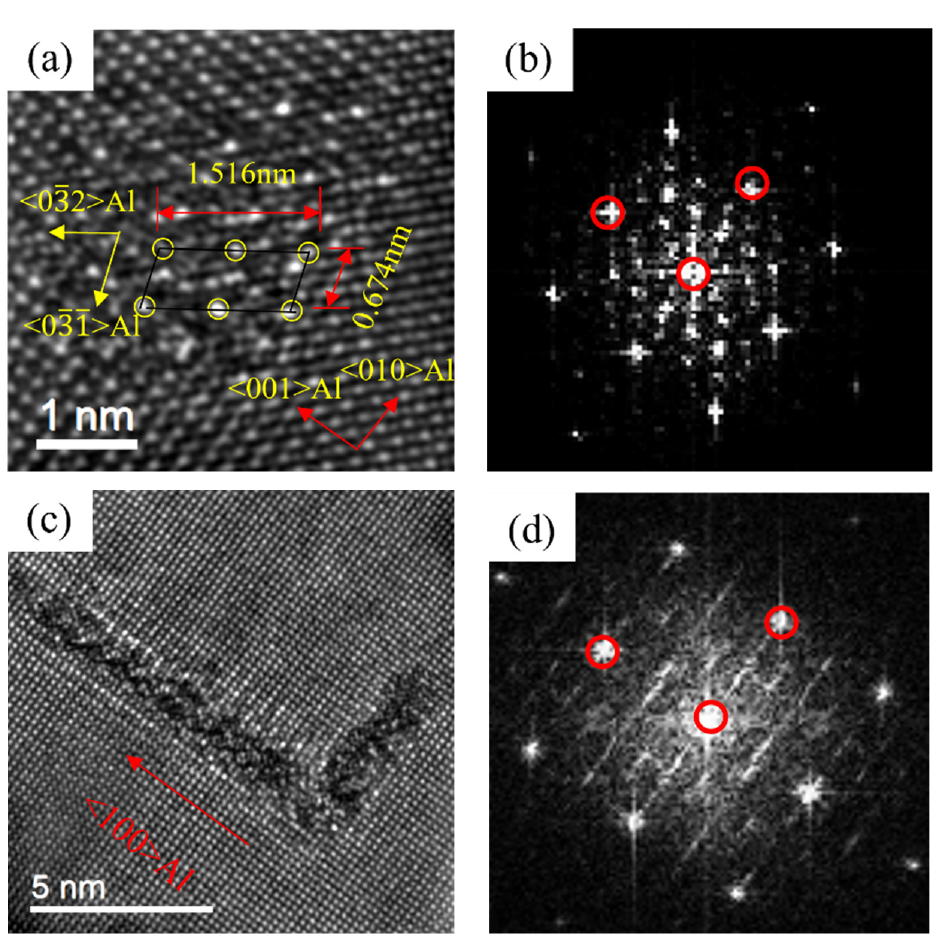
Figure 11. HRTEM and FFT patterns of the precipitates of 0.37Cu alloy after peak aging at 175 °C for 8 h. ( a , b ) β″ ; ( c , d ) L.